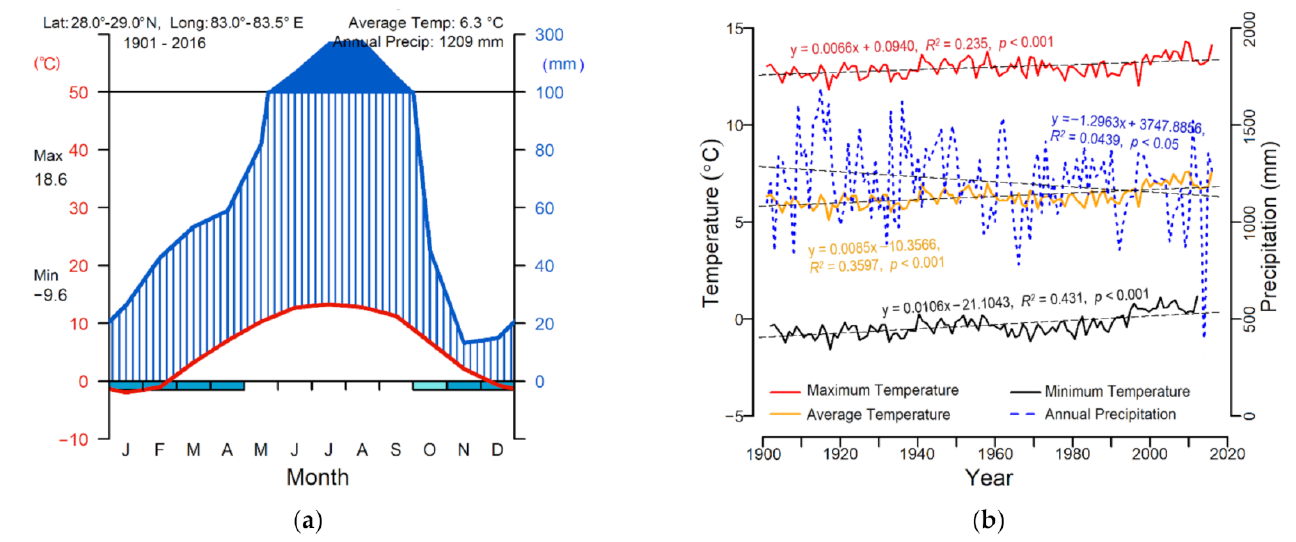
Figure 2. Climate chart of CRU grid average data. ( a ) Walter-Leith climograph, produced with the climatol R package [33], ( b ) Annual climate trend from the CRU data. The uppercase letters in the x-axis of Walter-Leith climograph are initial letters of twelve